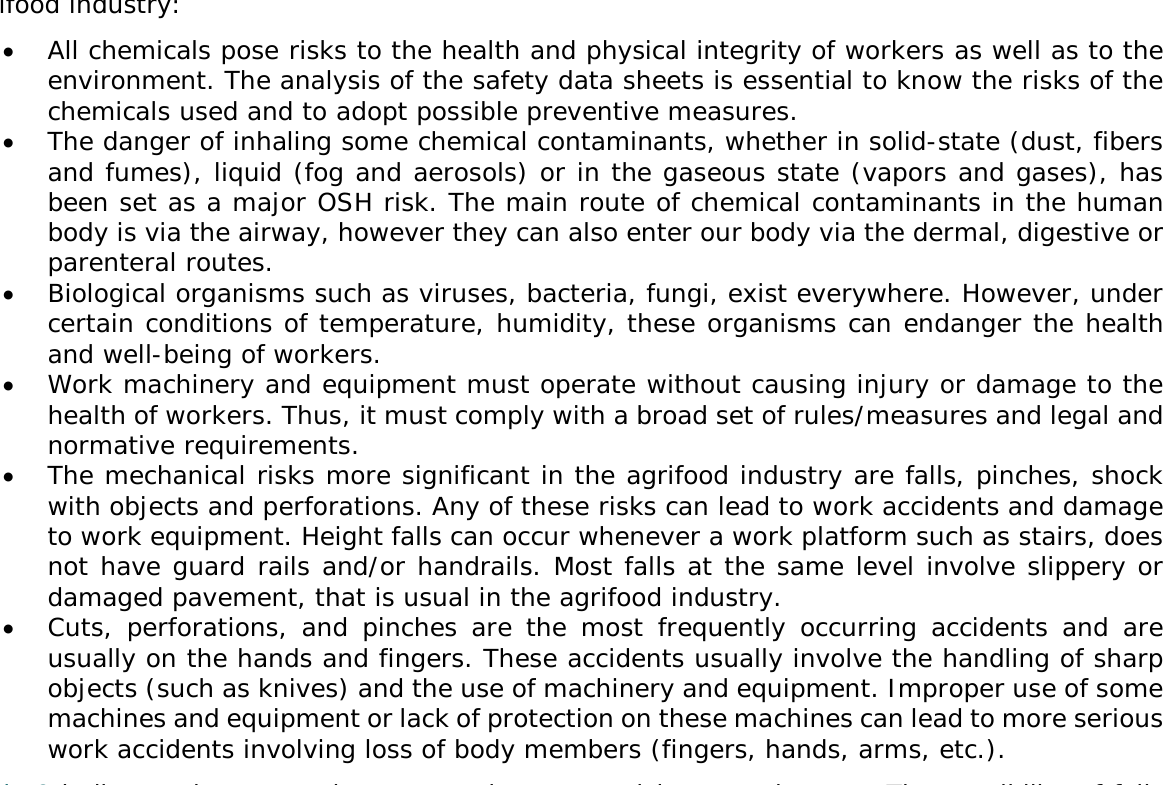
Tasks involving manual transport/lifting of loads?